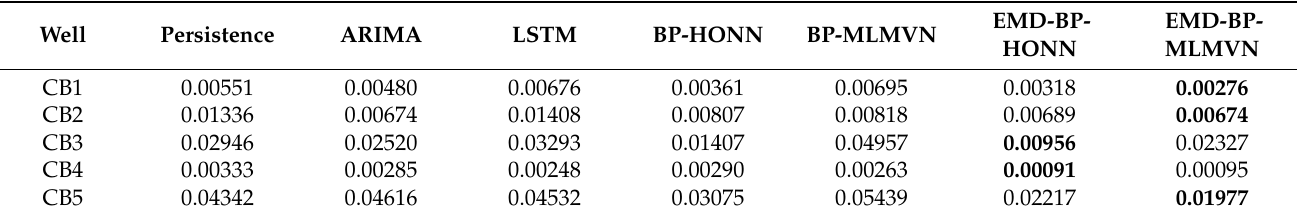
Table 5. Result of CB oilfield in RMSE metric. The lowest score is in bold.